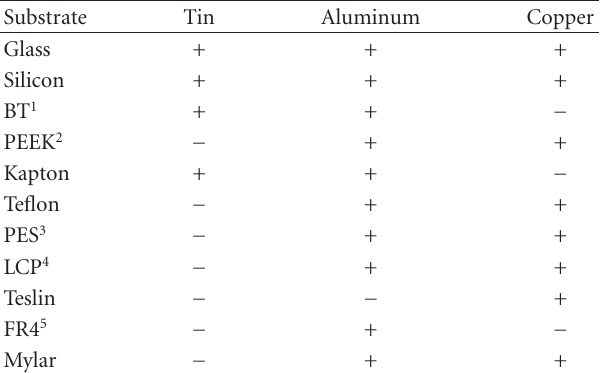
Table 4: MCS material-substrate compatibility, from Bhattacharya et al. [11], Copyright 2012 ASME. Reprinted with